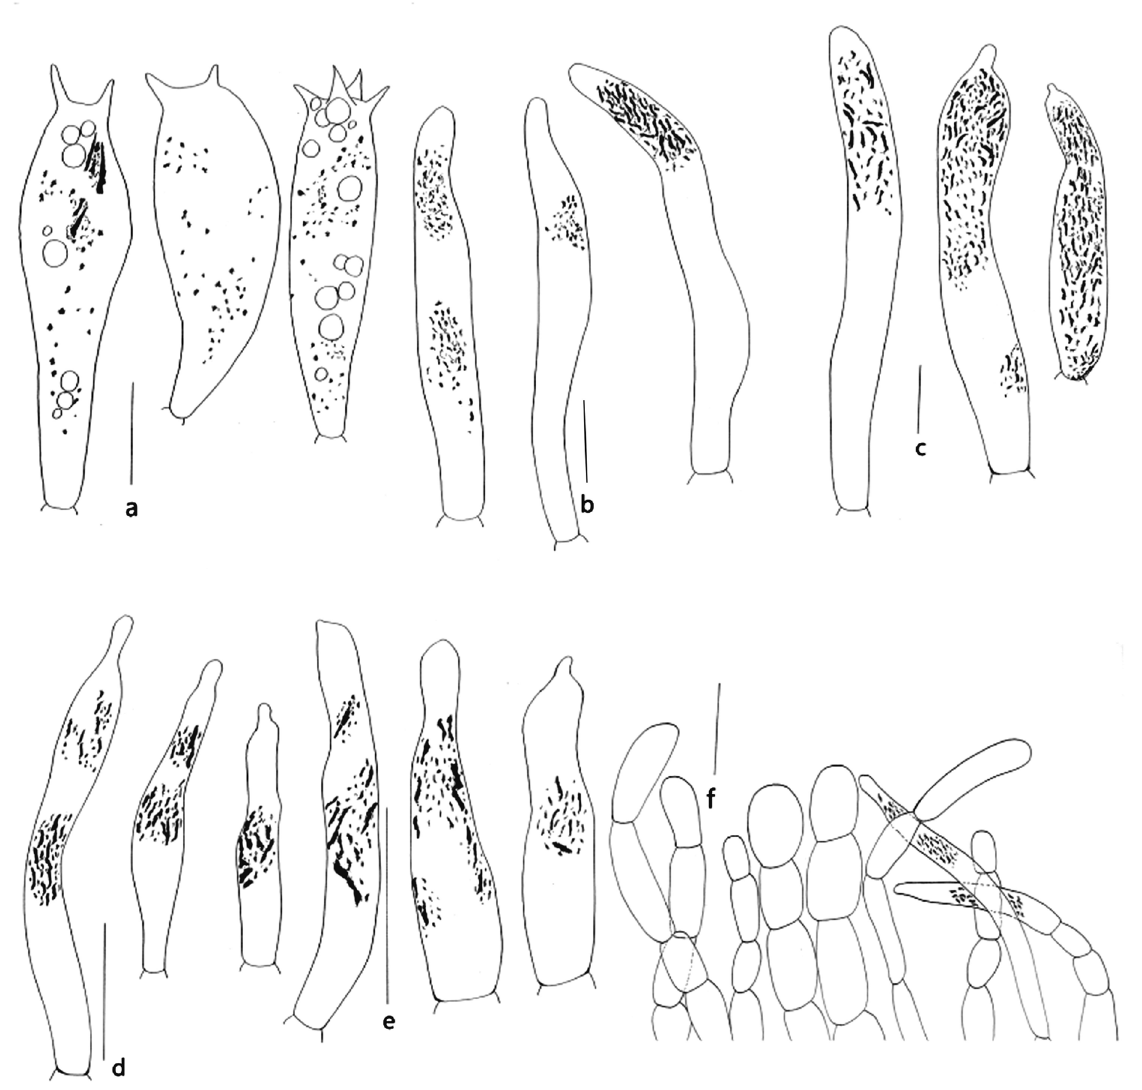
Fig. 5. Russula purpureorosea Y.Song sp. nov., holotype (GDGM75331). a . Basidia. b . Pleurocystidia. c . Cheilocystidia. d . Pileocystidia. e . Caulocystidia. f . Pileipellis. Scale bars = 10 μm.